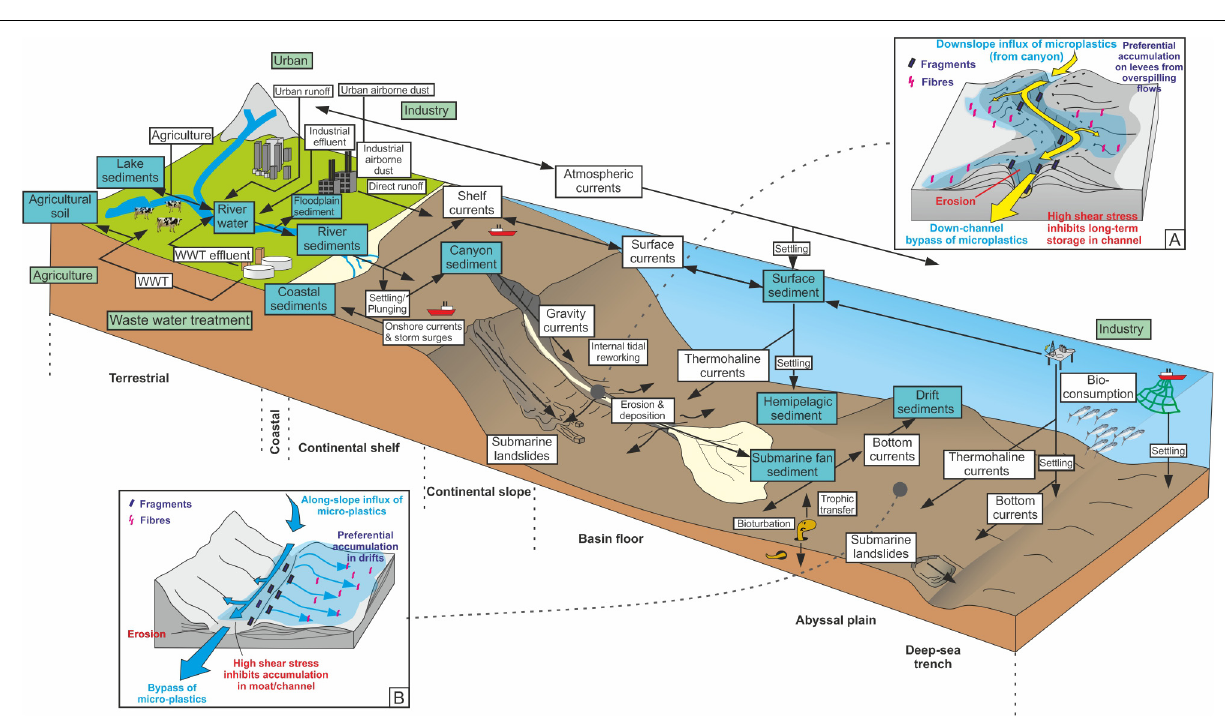
Frontiers in Earth Science |